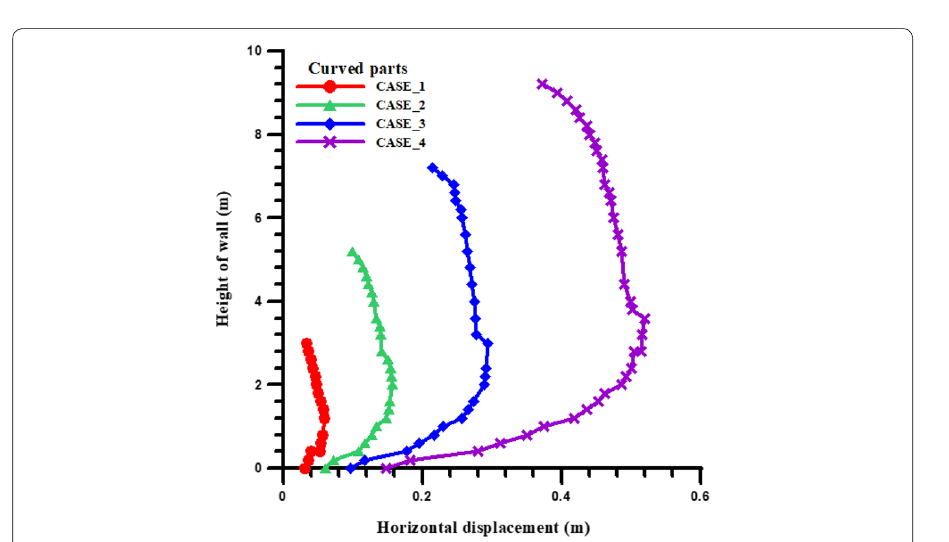
Fig. 10 Horizontal displacements for curved